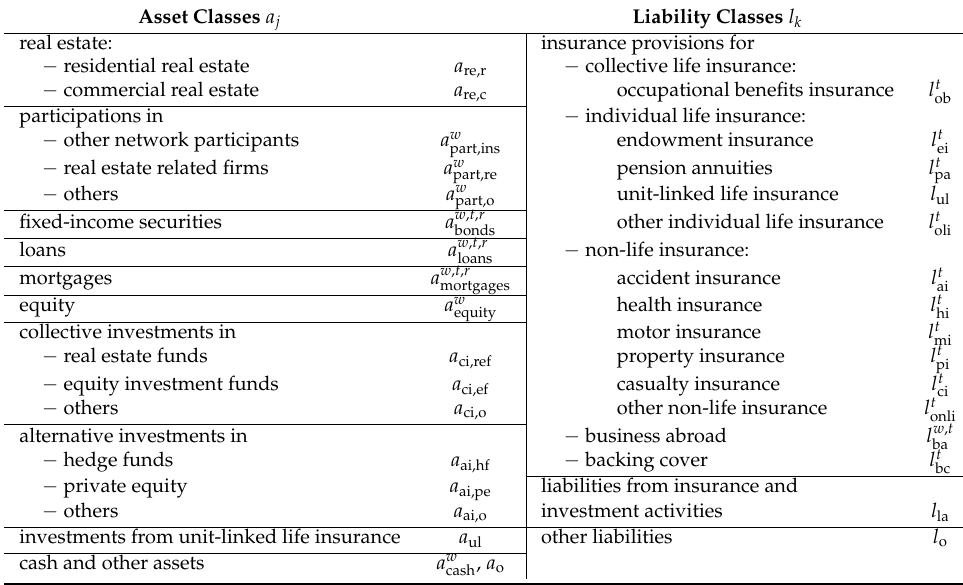
Table 1. Asset and liability classes under consideration, including their notation. The upper indexes run over maturity buckets t ∈ T , currencies w ∈ C and ratings r ∈ R ,